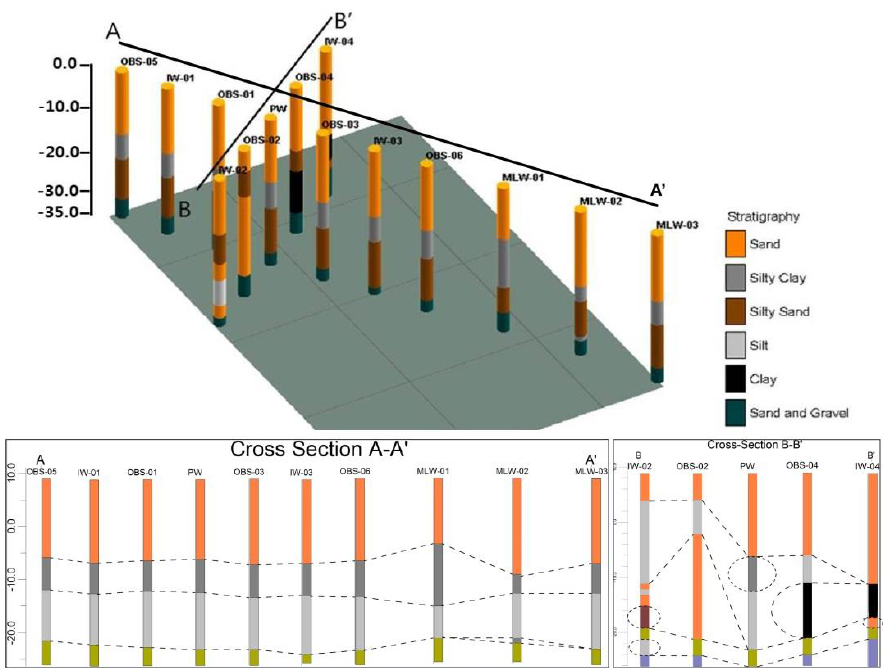
Figure 2. Subsurface geologic logs of the wells and cross-section A-A’ and B-B’.